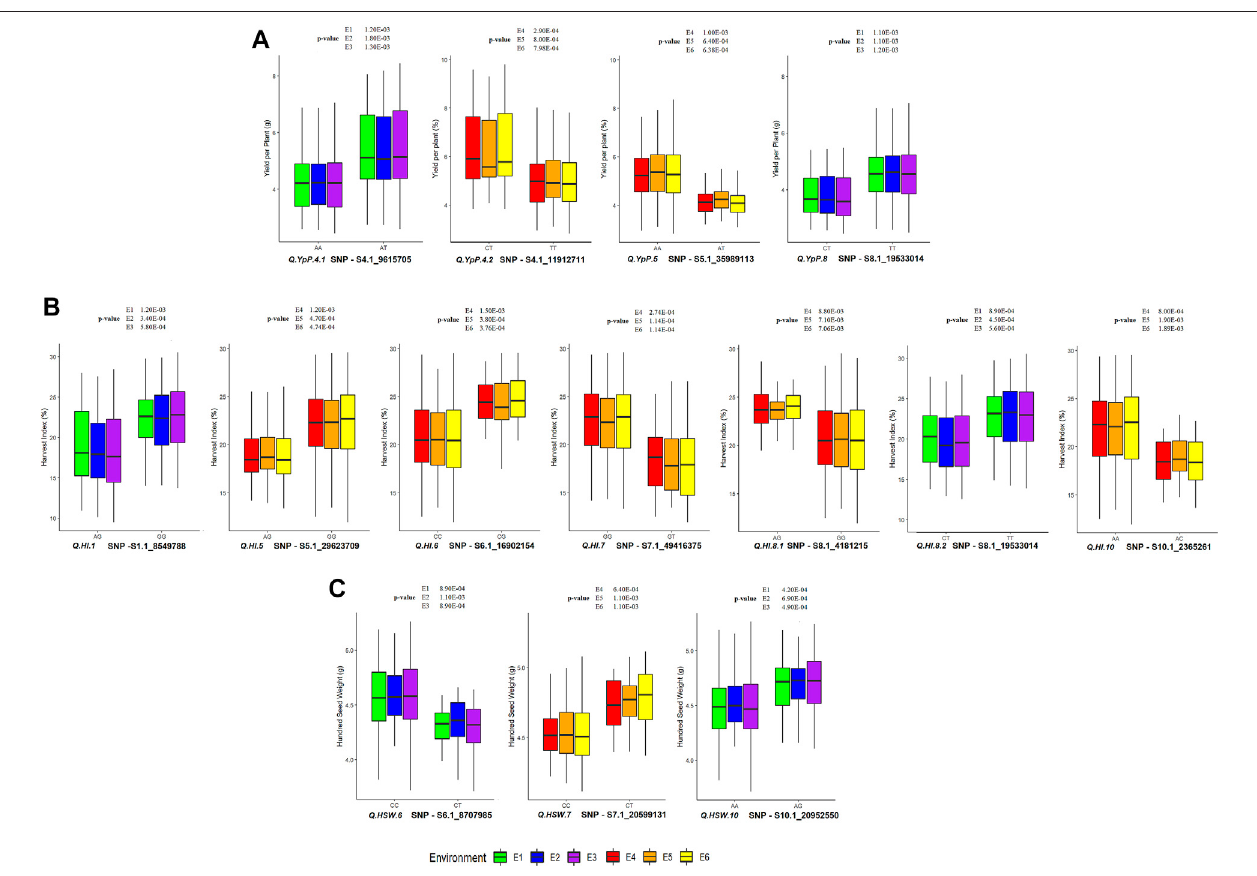
FIGURE6| AlleliceffectofQTLsassociatedwith (A) YpP(YieldperPlant); (B) HI(HarvestIndex)and (C) HSW(HundredSeedWeight)atLudhianaandGurdaspur. p -value is provided from t -test for the respective environment.